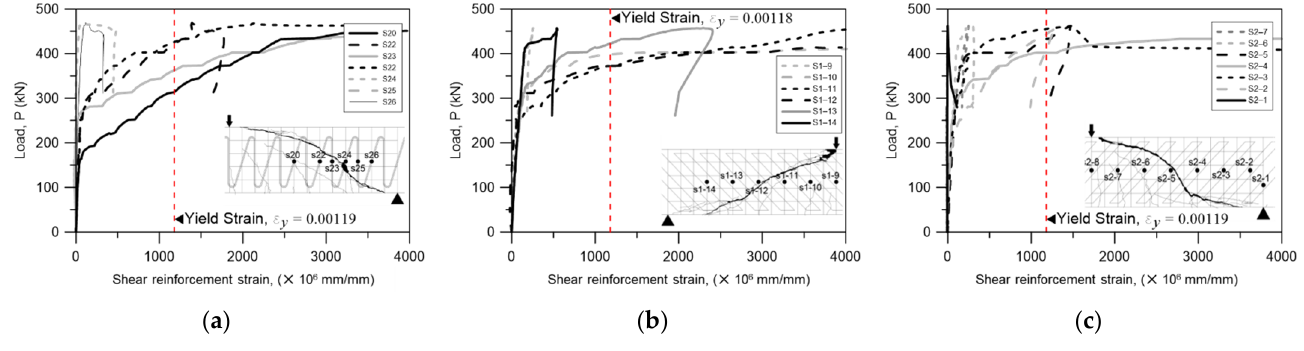
Figure 8. Strain of shear reinforcement. S x = strain gauge number. ( a ) BS-N. ( b ) BS-2T. ( c ) BS-2.5T.